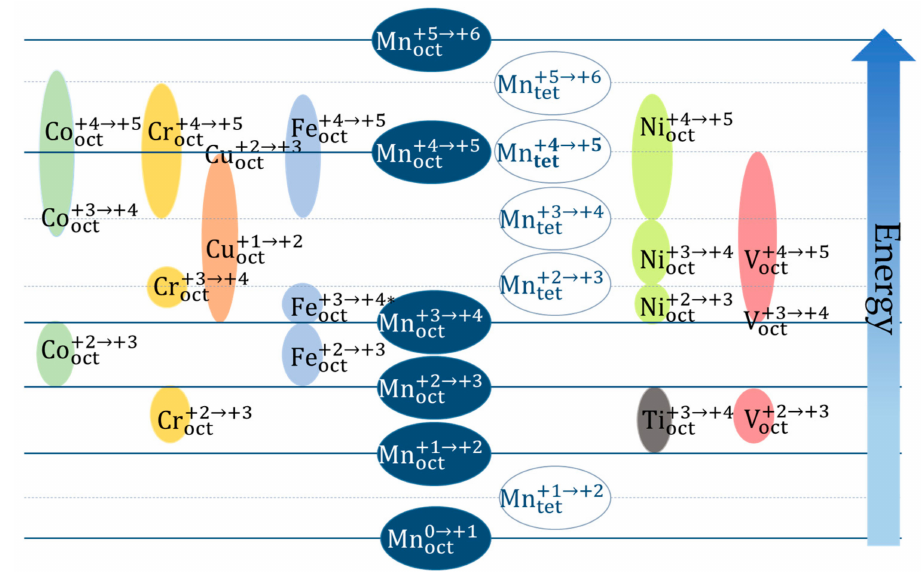
Figure 1. The ionization energies of 3d ions at various valences in an oxide framework (Adapted with permission from [2], Copyright 2004, American Chemical